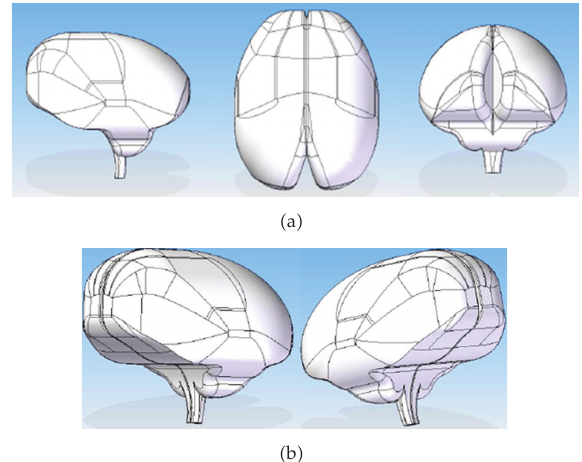
Figure 3: Principal and Isometric views of the brain